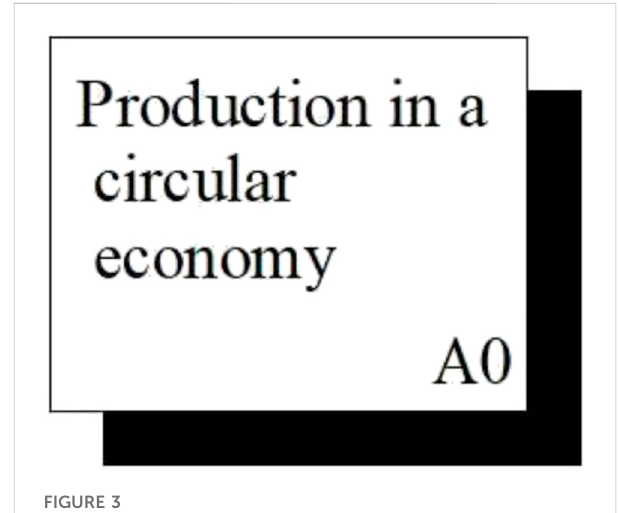
FIGURE 3 The top-level manufacturing-based CE IDEF0 diagram,